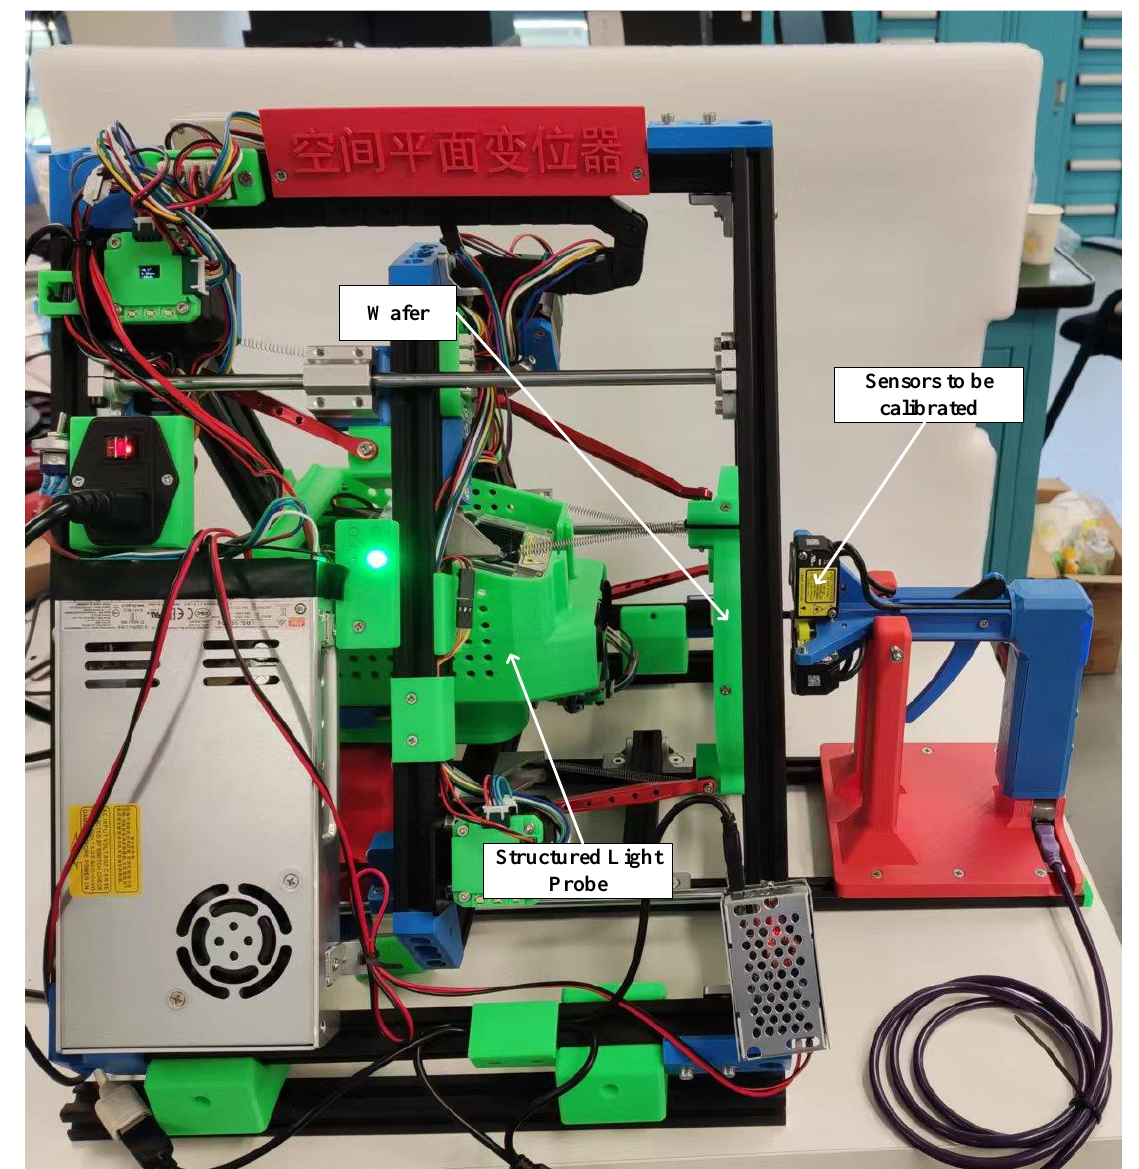
Figure 15. The experimental setup (characters in the nameplate means “Spacial Plane Position and Attitude Adjustment